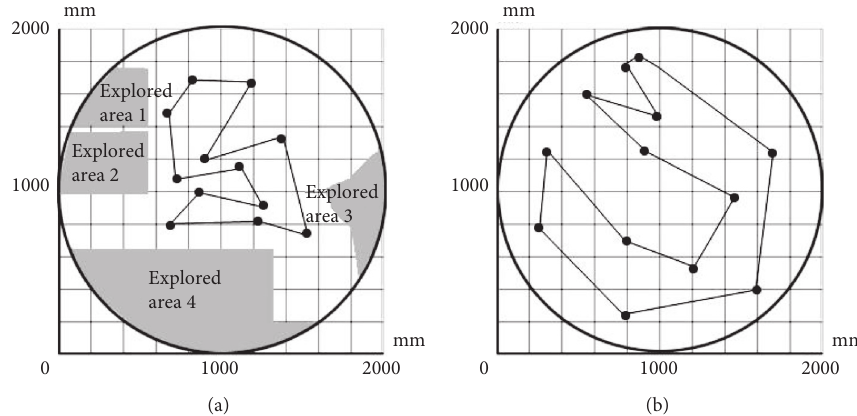
Figure 10: Comparison of search area after deconstruction and reconstruction with the random search area. (a) Search trajectory of improved parallel selection genetic algorithm. (b) Search trajectory of random